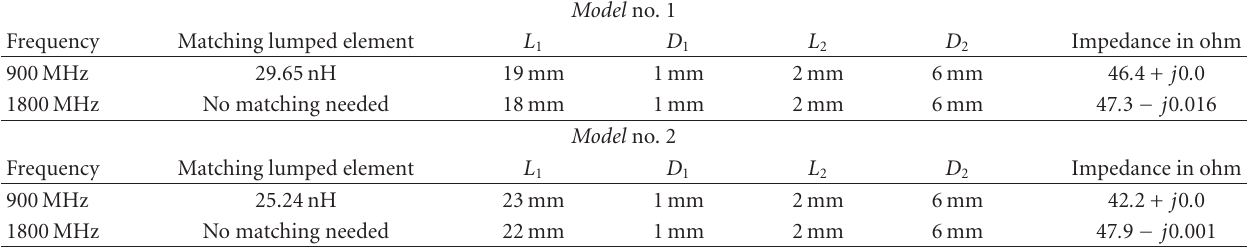
Table 1: The proposed antenna dimensions and specifications for both handset design models at di ff erent frequencies. Model no. 1